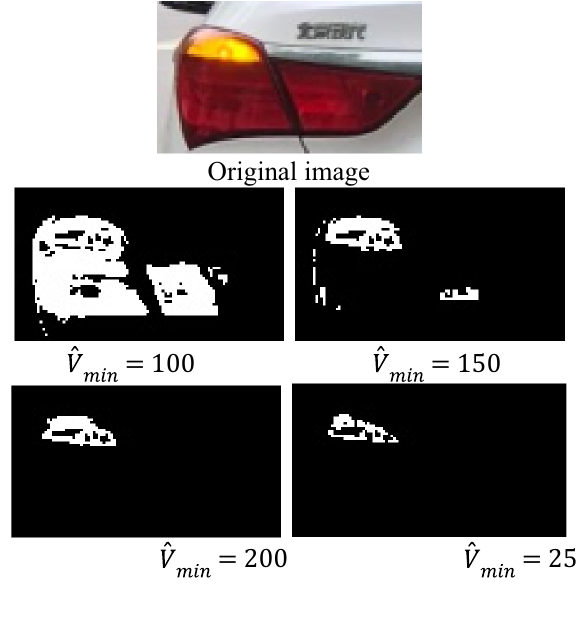
Fig. 6 HSV space threshold segmentation